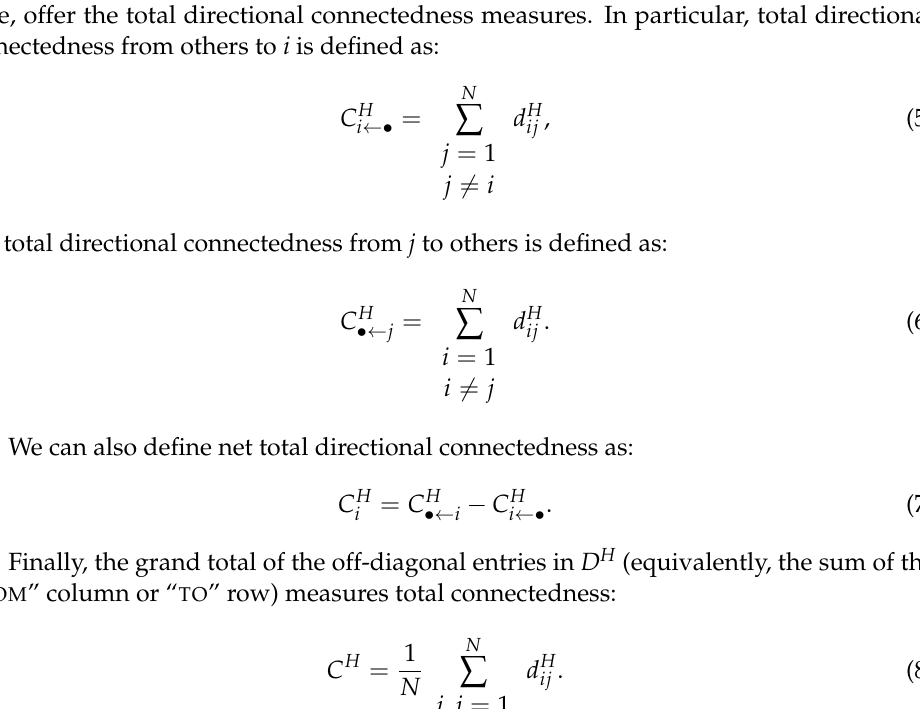
Connectedness FROM Others ∑ N d H , j (cid:54) = 1 j = 1 ij ∑ N d H , j (cid:54) = 2 j = 1 ij . . . ∑ N d H , j (cid:54) = N j = 1 ij N 1 ∑ d H , i (cid:54) = j N ij i , j = 1 Total